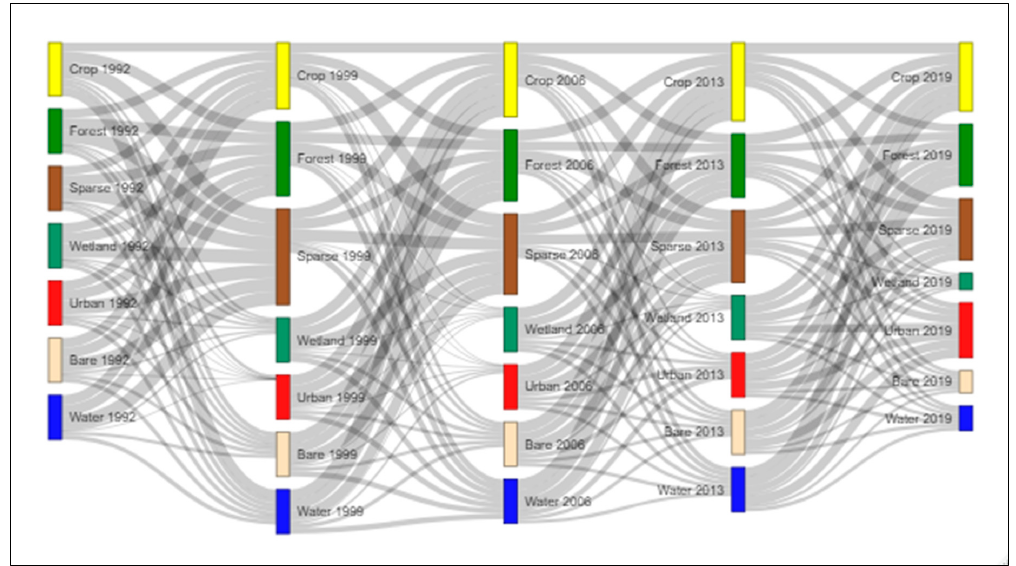
Figure 5. Land cover transitions from 1992–2019 over West Africa based on the IPCC classification scheme.